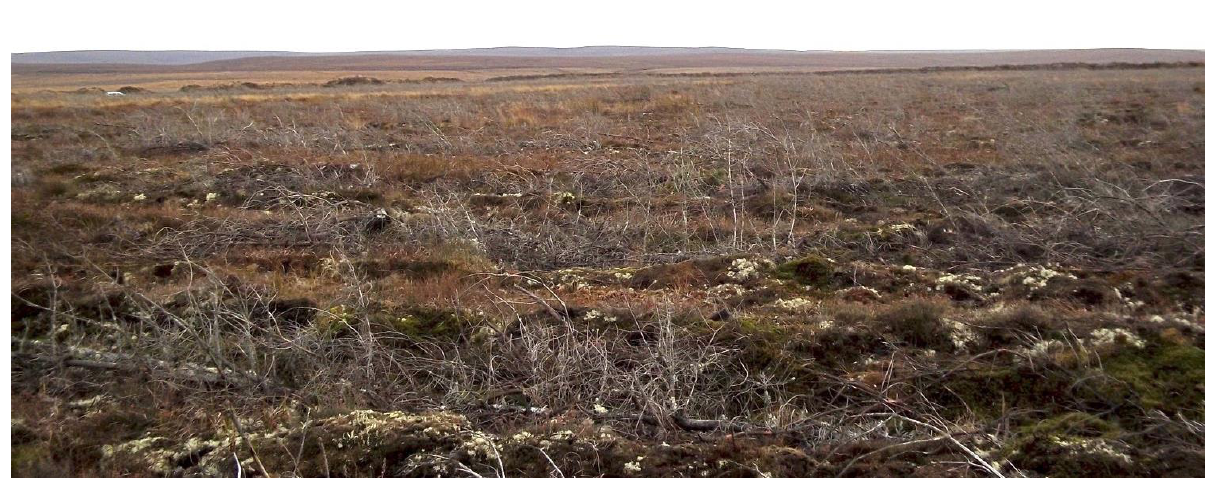
Figure 1. The Lonielist site in 2014. Vegetation is shorter than at the Talaheel site with small tussocks of Eriophorum spp ., visible in the picture. Woody debris is clearly visible in each of the furrows and is more abundant than Talaheel. Photo: Graham